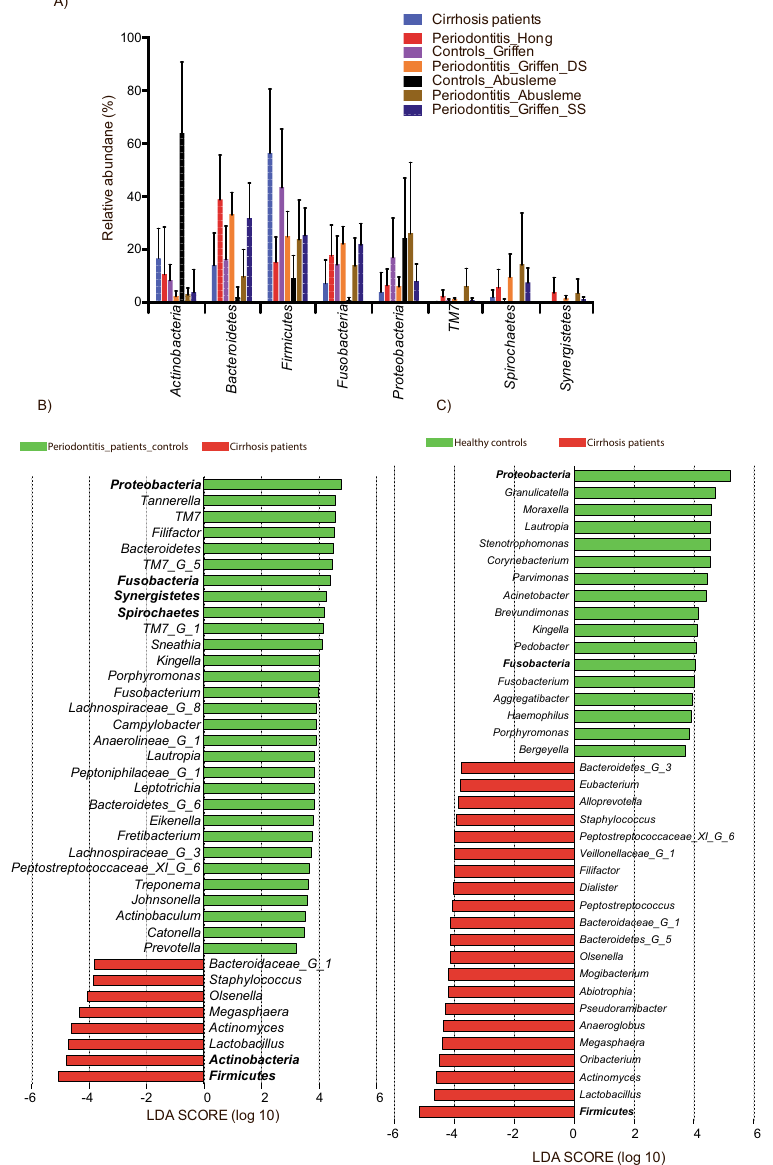
Figure 6. Relative abundance with standard deviation of the most abundant phyla detected in the groups after collectively processing of the reads from the present study and the studies of Hong 37 , Griffen 35 and Abusleme 36 ( A ) and differentially abundant bacterial phyla and genera identified by linear discriminant analysis (LDA) coupled with effect size measurements (LEfSe) between our samples and the pooled samples with periodontitis ( B ) and the pooled healthy control samples ( C ) from the three included studies. Only taxa that met the significant linear discriminant analysis threshold of 3.5 are shown. Phyla are written in